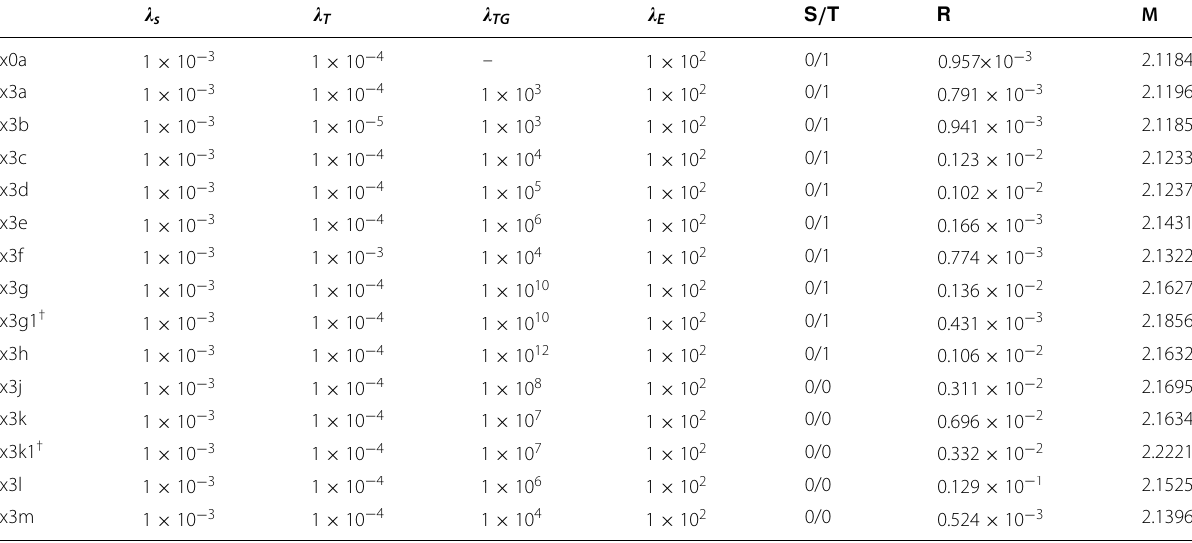
Table 3 Specification of damping parameters of the frozen-flux field model based on the tangential geostrophic flow assumption, except model x0a, which is based on a purely toroidal flow